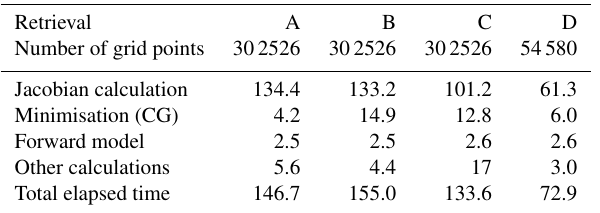
Table 3. Computational cost of retrievals (calculation times given in